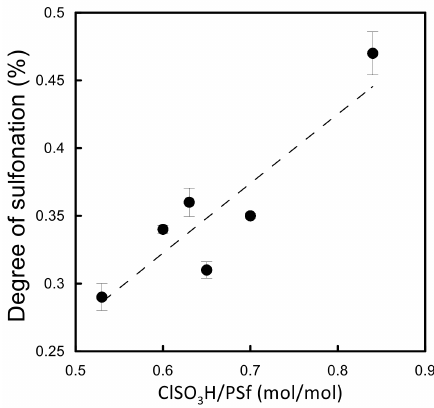
Figure 7. Relation between the reagent ratios and sulfonation